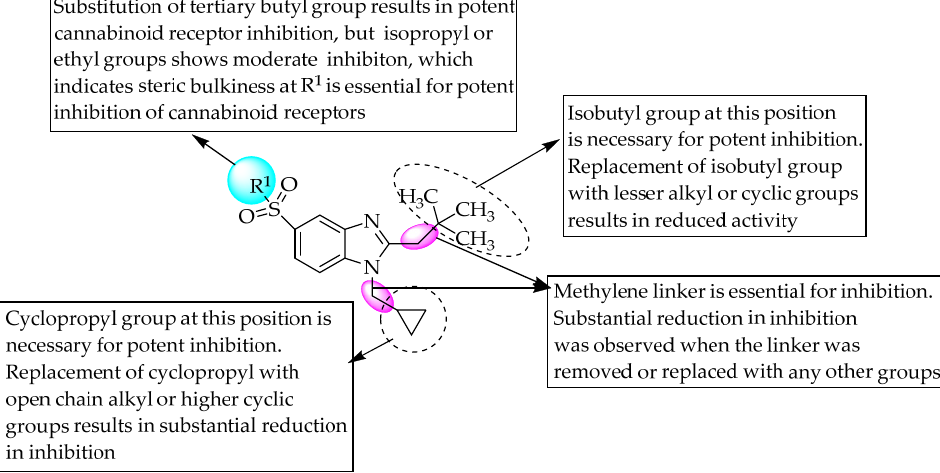
Figure 8. SARs of 5-sulfamoyl substituted benzimidazoles.